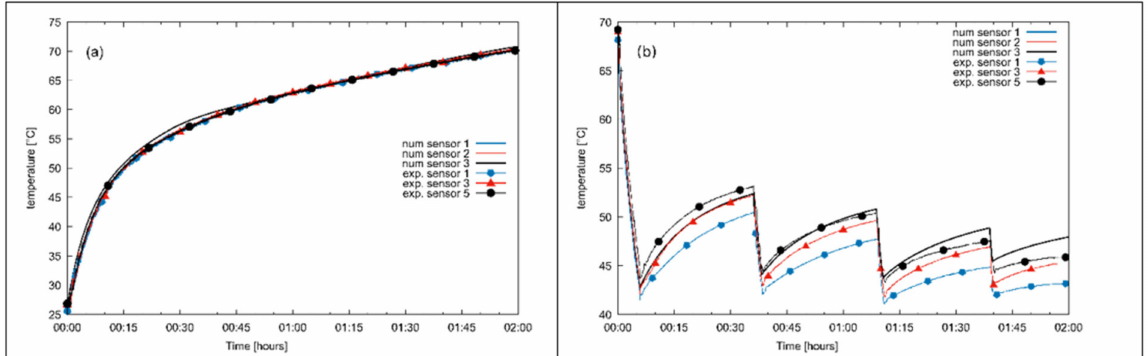
Figure 17. Results for Test 1 charge problem ( a ) and Test 2 discharge top view; ( b ) symmetry plane